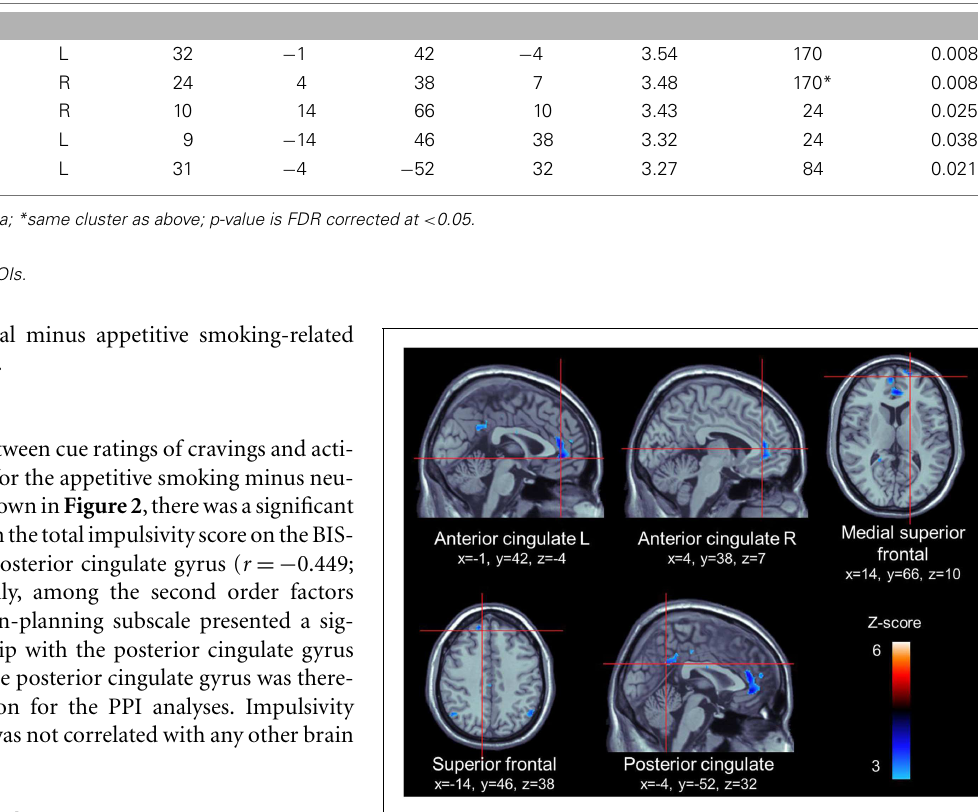
FIGURE 1 | ROI activations during viewing of appetitive cigarette images (relative to neutral images) . All highlighted regions in this figure were significantly activated.Transition from blue to red color represents increases in z